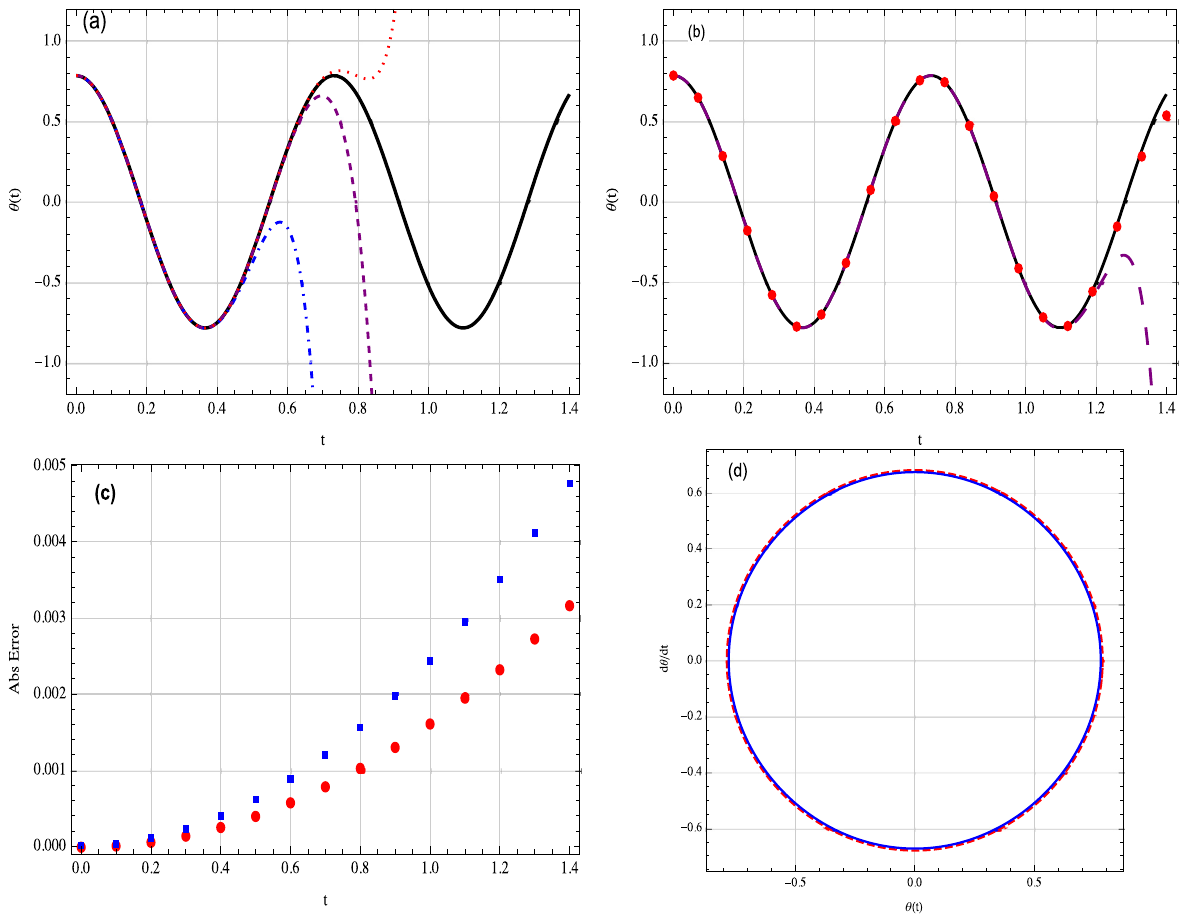
Figure 2: ( a ) Comparison of the MDM approximation θ t π , 0, 4, 0 10 ( ) / ( dash - dotted line ) , θ t π , 0, 4, 0 14 ( ) / ( dashed line ) , θ t π , 0, 4, 0 16 ( ) / ( dotted line ) and the exact solution ( solid line ) . ( b ) The exact solution ( solid line ) , the 20th - order MDM numeric solution θ h 0.25 = ( dashed line ) , and the 25th - order MDM numeric solution θ 25 ⟨ ⟩ with the exact solution ( dots ) and the 25th - order ADM numeric solution ( squares ) , respectively. ( d ) Phase plane diagram, exact ( solid θ k 25 ⟨ ⟩ approximation ( dashed line ) for Example line ) and θ k